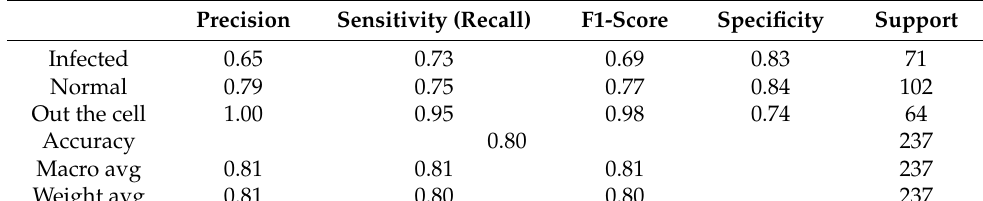
Table 4. Efficiency of the model evaluated by blind sample data sets (test set).